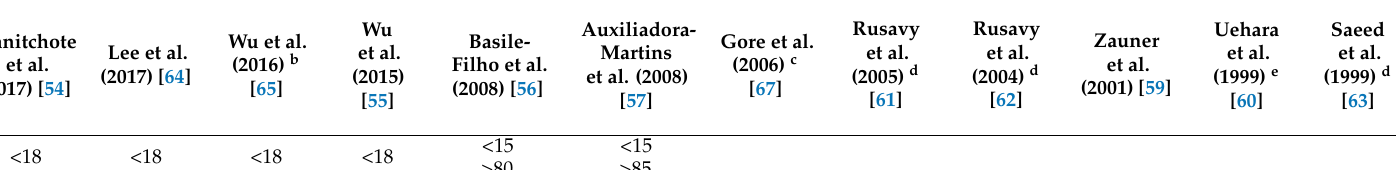
Table 3. Summary of study exclusion